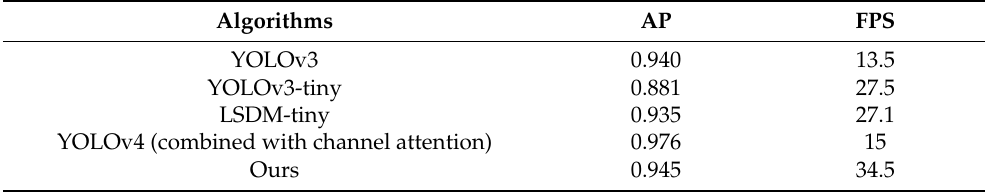
Table 1. Comparison of accuracy and speed performance of different target detection algorithms.